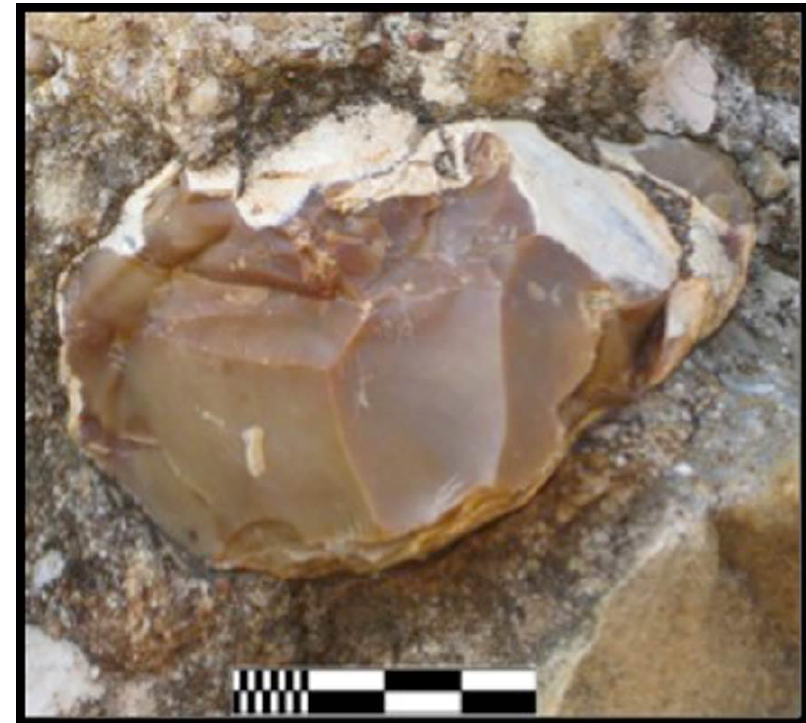
Figure 5. Chert sample from Font de la Salut Conglomerates outcrop (Traiguera, Castelló).